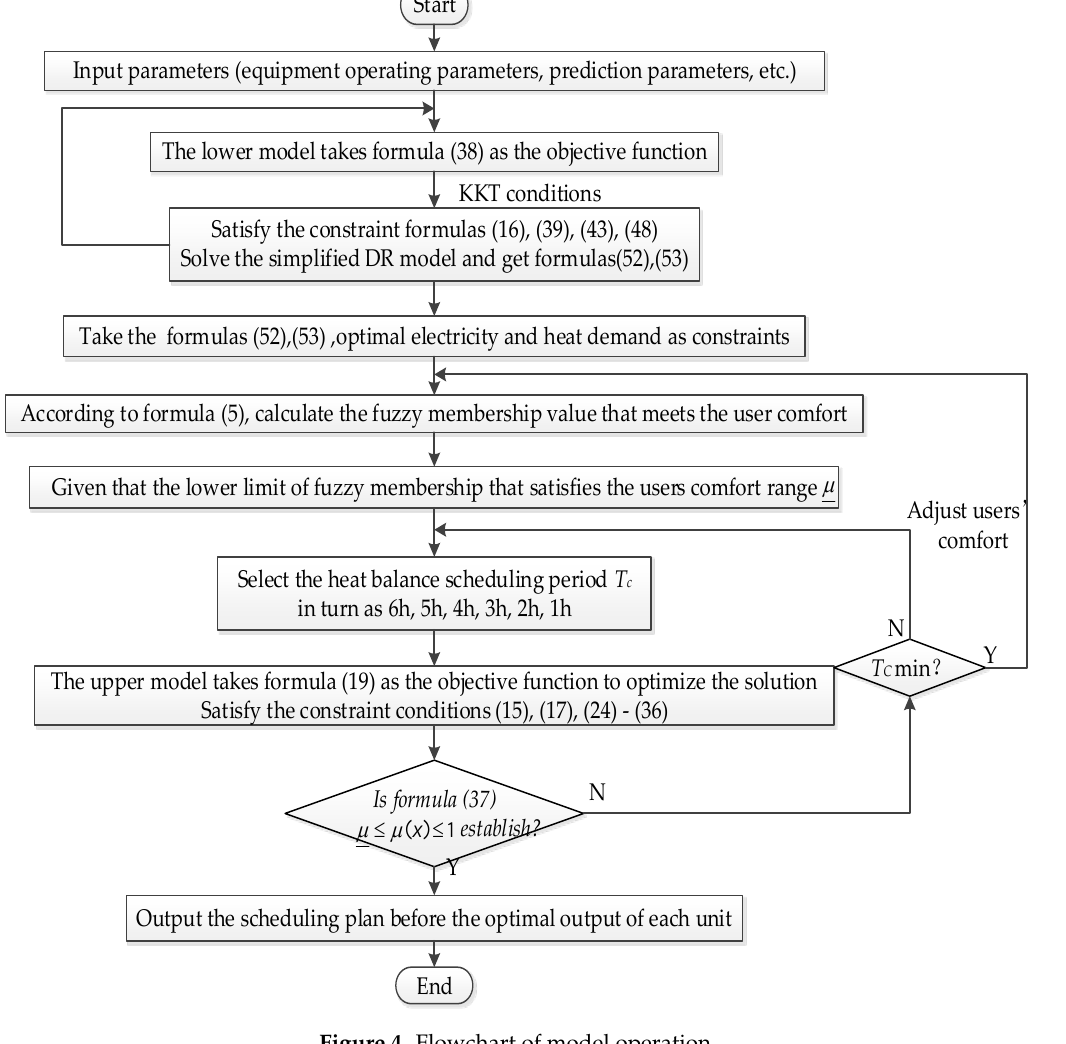
Figure 4. Flowchart of model operation.